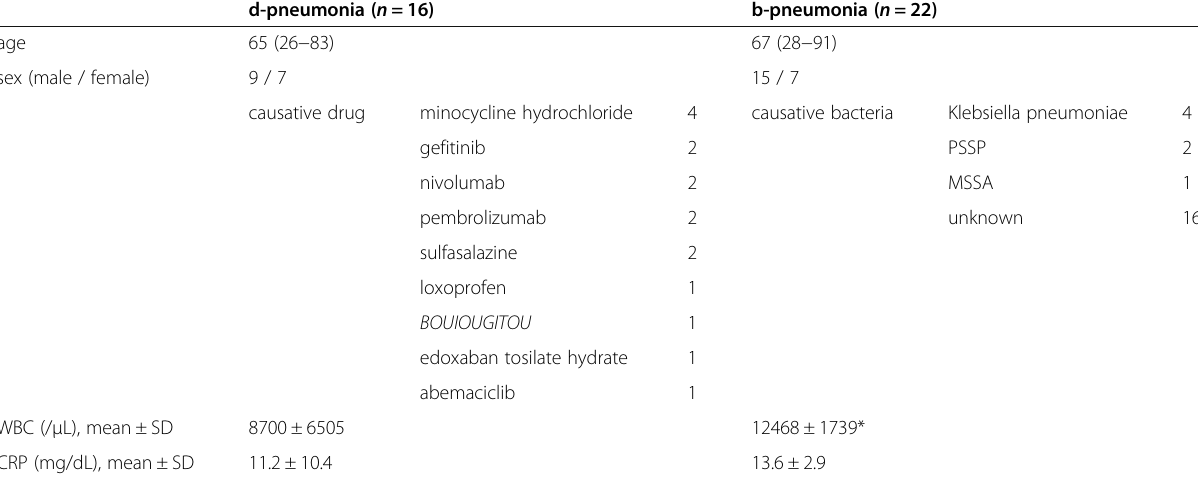
Table 1 Patient